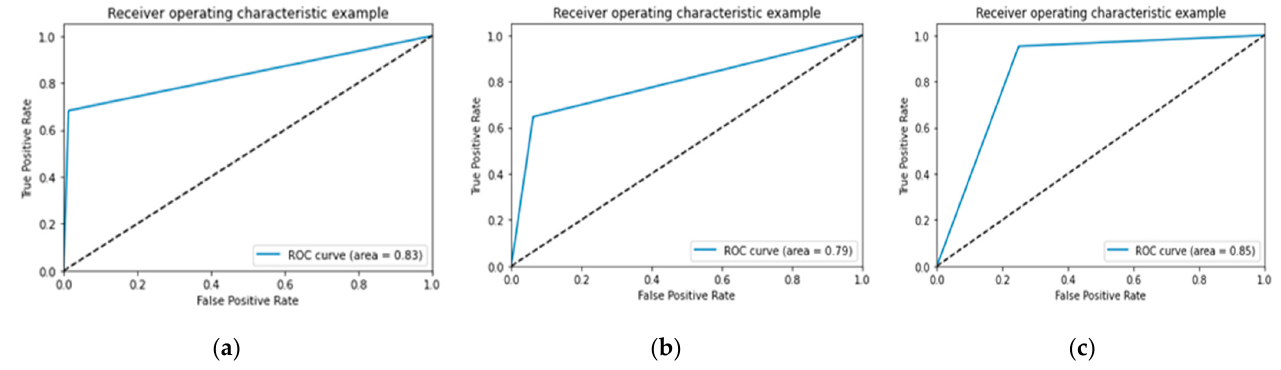
infarction; ( b ) ischemia; ( c ) normal.